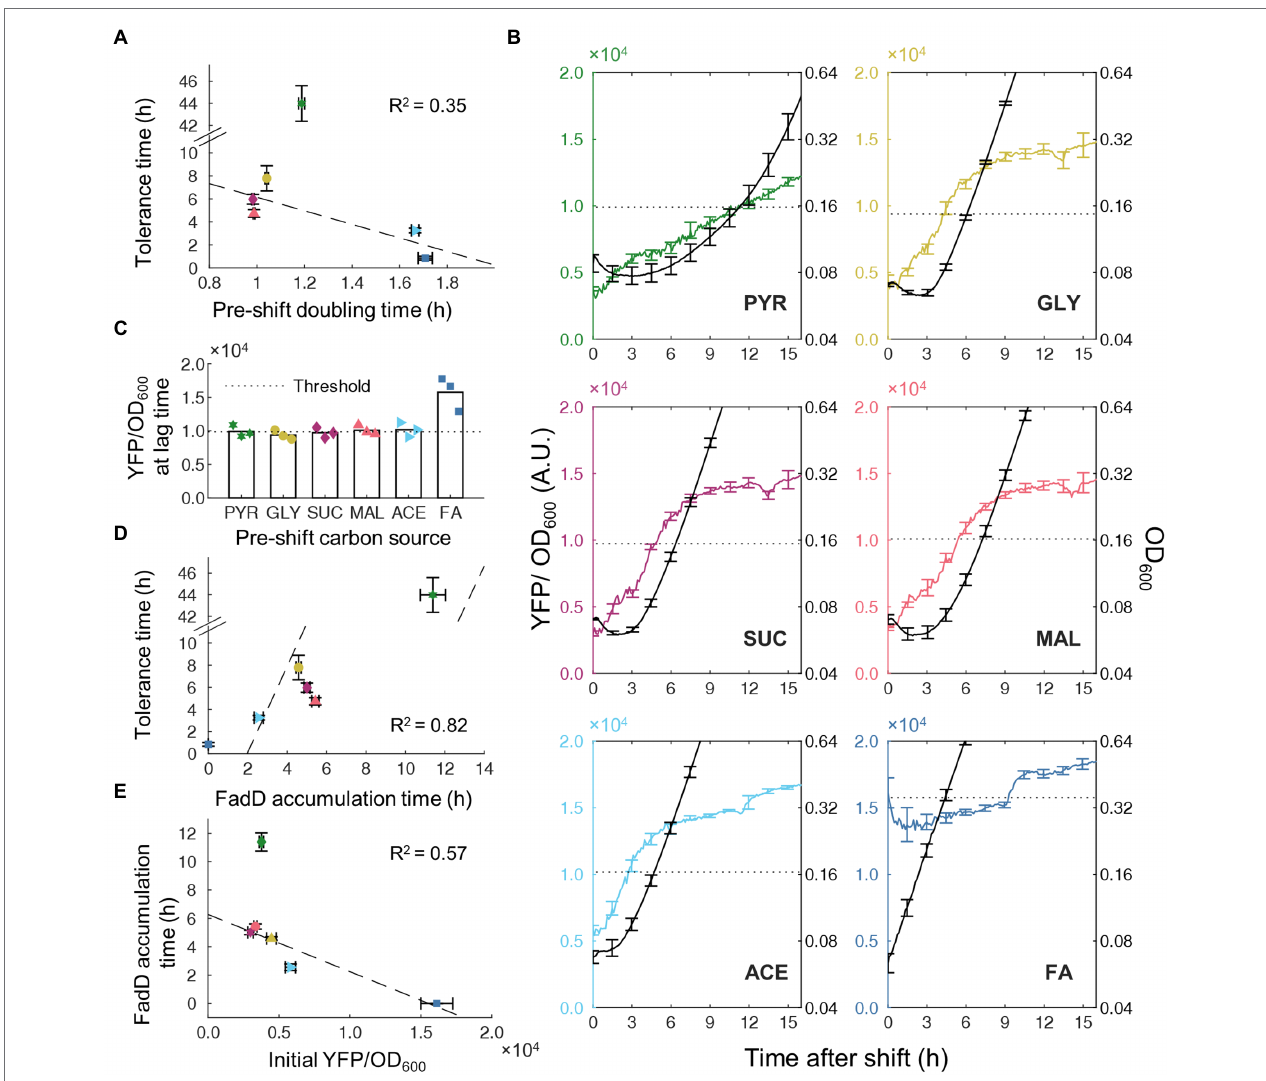
FIGURE 3 | Timing of FadD accumulation associated with transient tolerance time. (A) Correlation between measured tolerance time and growth rate in pre-switch carbon source. Dashed line is least-squares linear fit to data with bisquare weighting. (B) Time course of YFP/OD 600 from FadD-YFP fusion (colored line, left axis) and OD 600 (black line, right axis) after shifts from a gluconeogenic carbon source to FA, n = 3, Error bars represent SEM. The dotted line indicates the YFP/OD 600 level when cells resume steady state growth. (C) Average YFP/OD 600 from FadD-YFP fusion at the end of the lag phase, n = 3. Values from individual replicates shown as points. The dashed line (namely the FadD threshold) shows the average FadD concentration at the end of lag phase across all pre-shift conditions except FA. (D) Correlation between tolerance time and FadD accumulation time (time for FadD to reach the threshold level). Tolerance time was obtained from data in Figure 2B . Dashed line is a linear fit. (E) Correlation between YFP/OD 600 value at the steady state of pre-culture and FadD accumulation time. Dashed line is a least- squares linear fit with bisquare